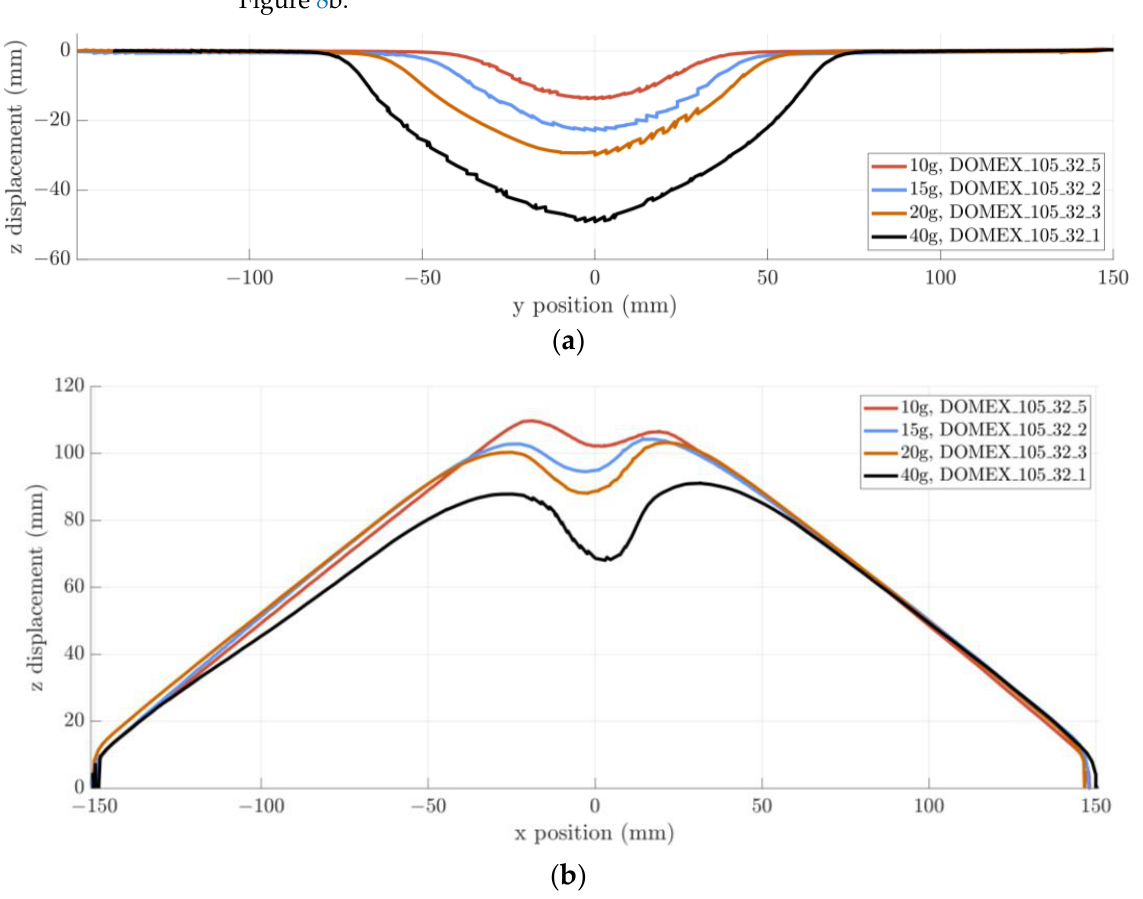
Figure 8. Permanently deformed profiles of blast tested V-structures (105 ◦ internal angle, 32 mm tip